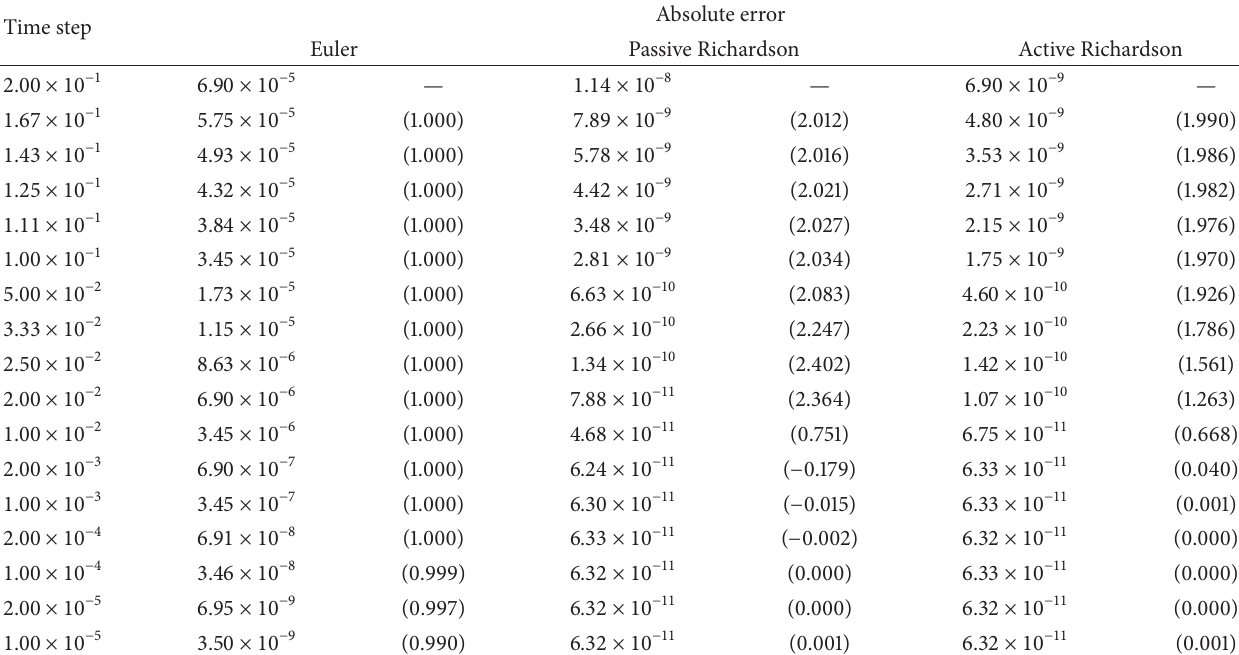
Table 3: Absolute error of the diffusion problem with linear reaction term without and with passive/active Richardson extrapolation (with the estimated convergence order in parentheses).